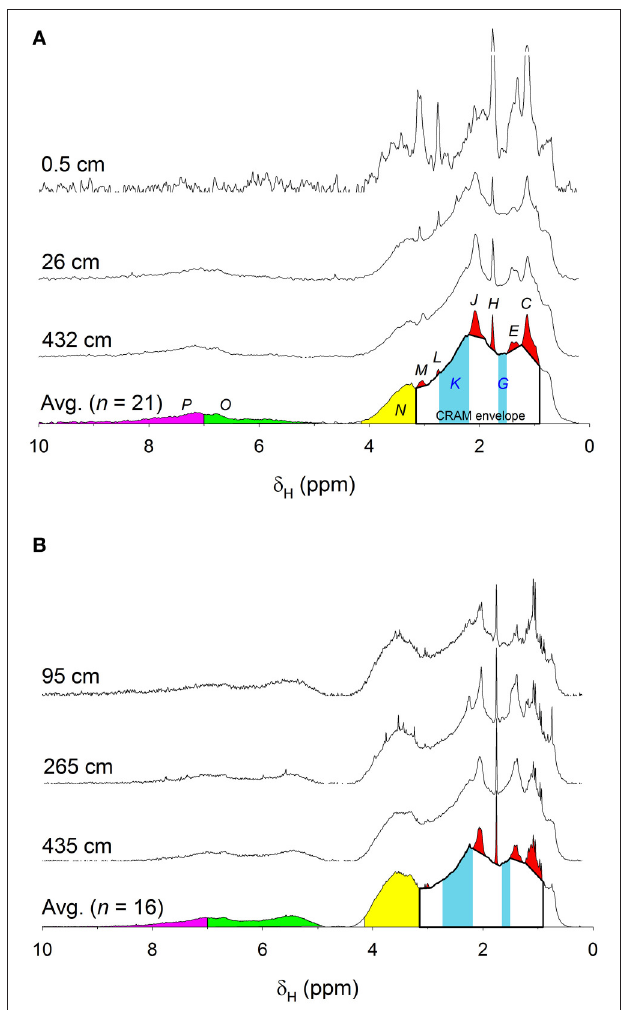
FIGURE 2 | Area-normalized 1 H NMR spectra acquired on a spectrometer operating at (A) 400 MHz ( n = 21), and (B) 600 MHz ( n = 16). Three example spectra (from shallowest, intermediate, and deepest depth intervals) are shown along with the average of all n samples. Labels C - P indicate peak/band assignments ( Table 2 ). Area under the unresolved envelope between δ H 0.9–3.2 ppm has been assigned to CRAM. CRAM constituents G and K are shown as solid blue sections. δ H 4.1–4.9 ppm (where the water peak appears) was excluded from all